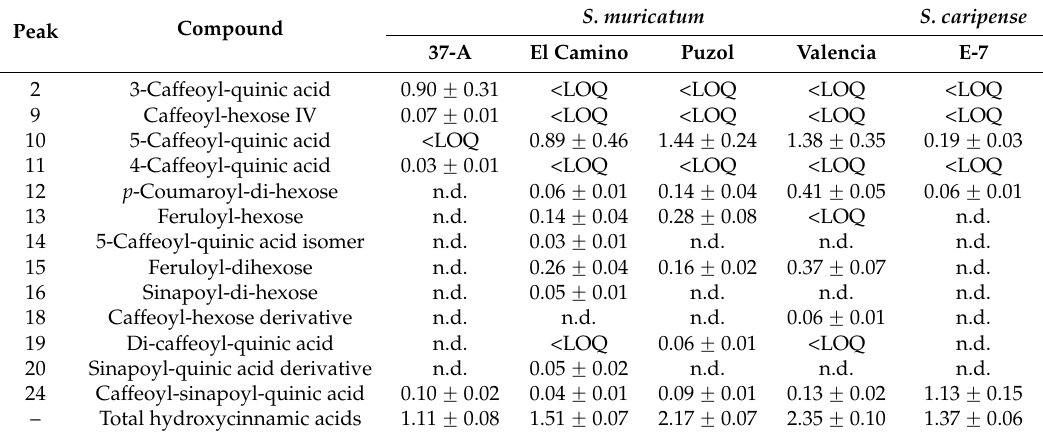
Table 2. Compounds quantified (mg/g dry weight) in fruit samples of pepino ( S. muricatum ) and its wild relative S. caripense samples by HPLC-DAD.